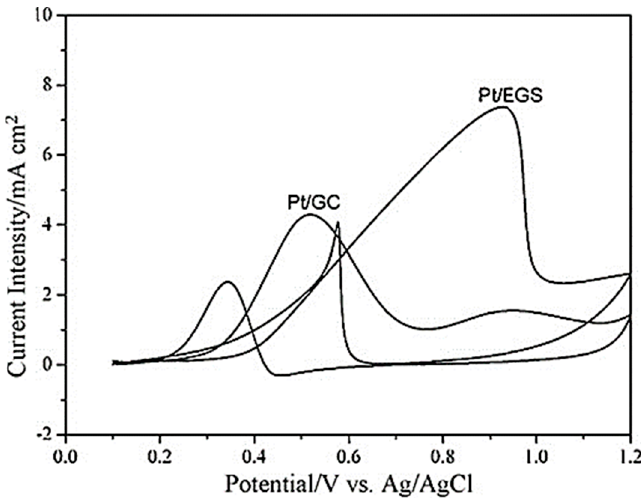
Figure 7. CV curves of Pt/EGS and Pt/GC electrodes in mixed solution of 0.5 M CH 3 OH and 0.5 M H 2 SO 4 at 5 mVs − 1 [101]. Pt/EGS = Platinum/expandable graphene sheet; Pt/GC = Platinum/glass carbon composite electrode. Reproduced with permission from Elsevier.